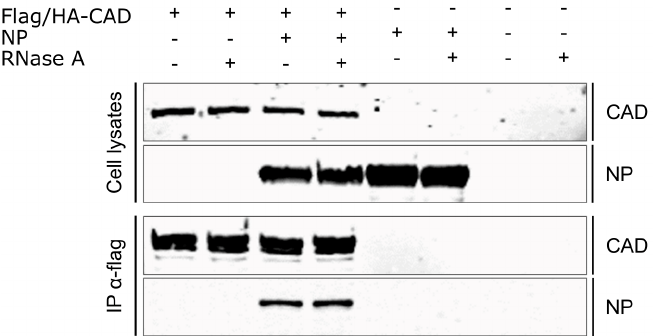
Figure 7. Interaction of CAD with NP. 293T cells were transfected with plasmids encoding FLAG / HA-CAD and EBOV-NP. 48 h post-transfection, the cells were lysed and treated with RNase A (100 µ g / mL) or remained untreated. FLAG / HA-CAD was precipitated using anti-FLAG antibodies, and input and precipitates were analyzed via SDS-PAGE and Western blotting using anti-FLAG and anti-NP antibodies. In the CAD IP sample, several bands for CAD are visible, possibly due to posttranslational modifications that are not visible in the lysates because of the overall lower CAD signals in those